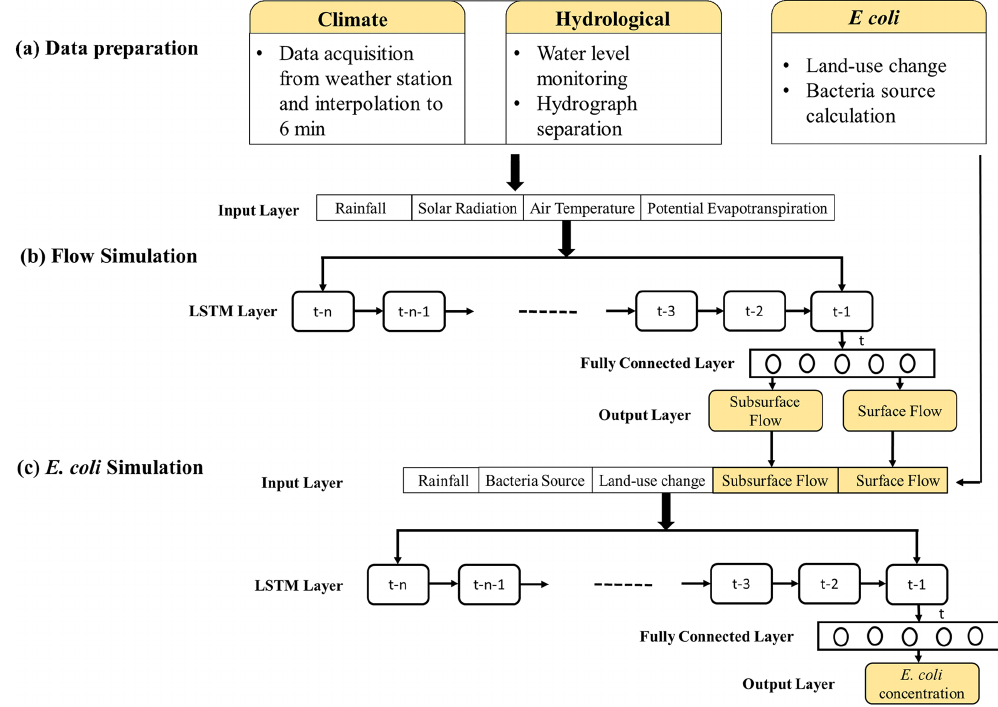
Figure 2. Structure of the LSTM model. Environmental data are used to predict surface flow and subsurface flow. Simulated flows along with bacteria source, land-use information, and rainfall are used to simulate E. coli concentration. The “ n ” represents the length of input data used by